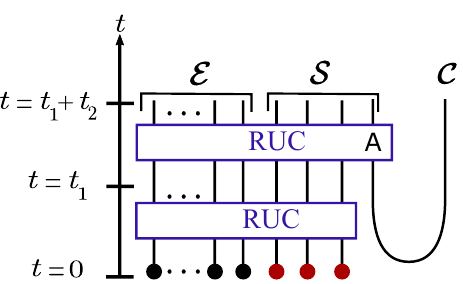
Figure 12 . Pictorial representation of the third settings considered in section 4. We initialize the system (the \black hole") in a product state, except for a qubit A , randomly chosen, which is S maximally entangled with an ancillary one, denoted by RUC with a U(1) conserved charge for a time t 1 . After that, for a time t 2 .